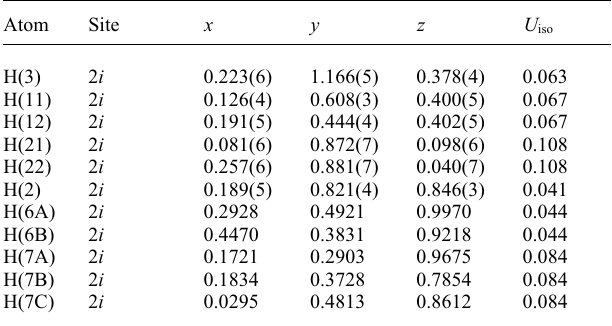
Table 2. Atomic coordinates and displacement parameters (in Å 2 ) .